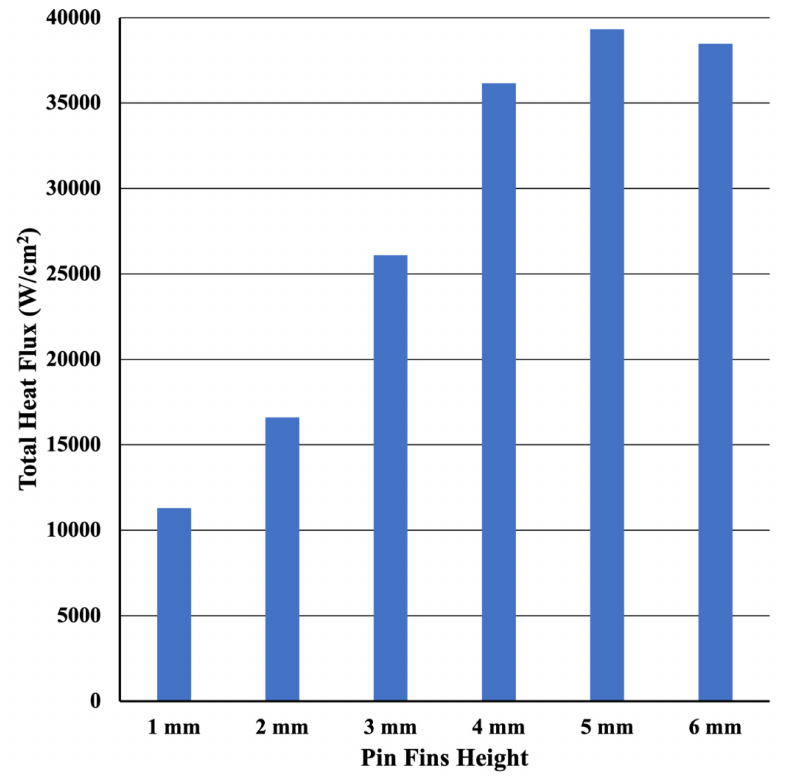
Figure 17. Average total heat flux at the top phase change material